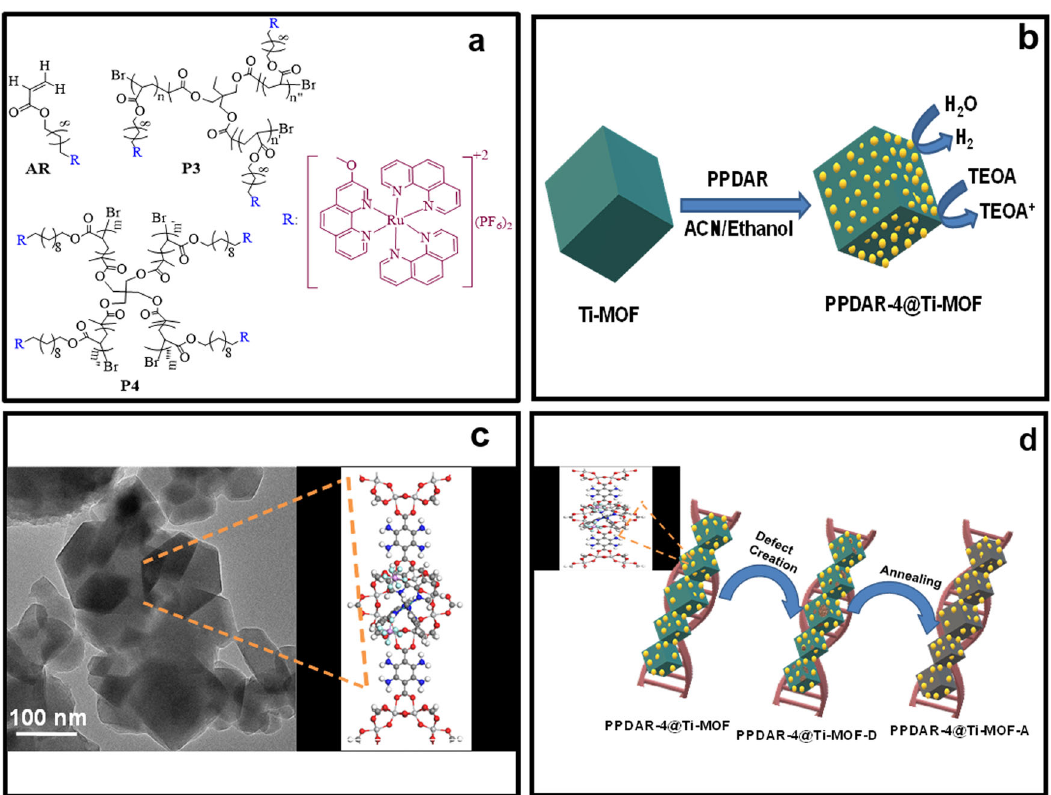
Fig. 7 Chemical structures and mechanistic pathway. a Chemical structures of the acrylate ruthenium (AR or P1) complex, 3-armed AR polymer (PPDAR- 3) and 4-armed AR polymer (PPDAR-4), b mechanistic pathway for hydrogen production, c TEM with the structure image of Ti-MOF, and d Schematic view of the modi fi cation